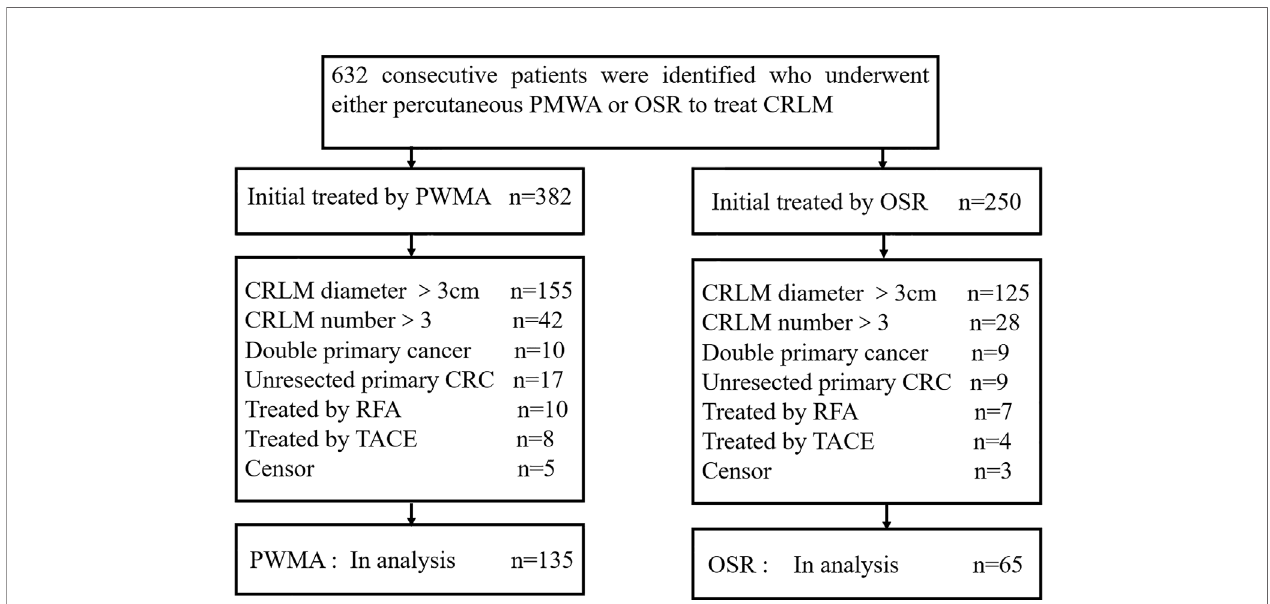
FIGURE 1 | Flowchart of the study population. ORS: open surgical resection; PMWA: percutaneous microwave ablation; CRC: colorectal